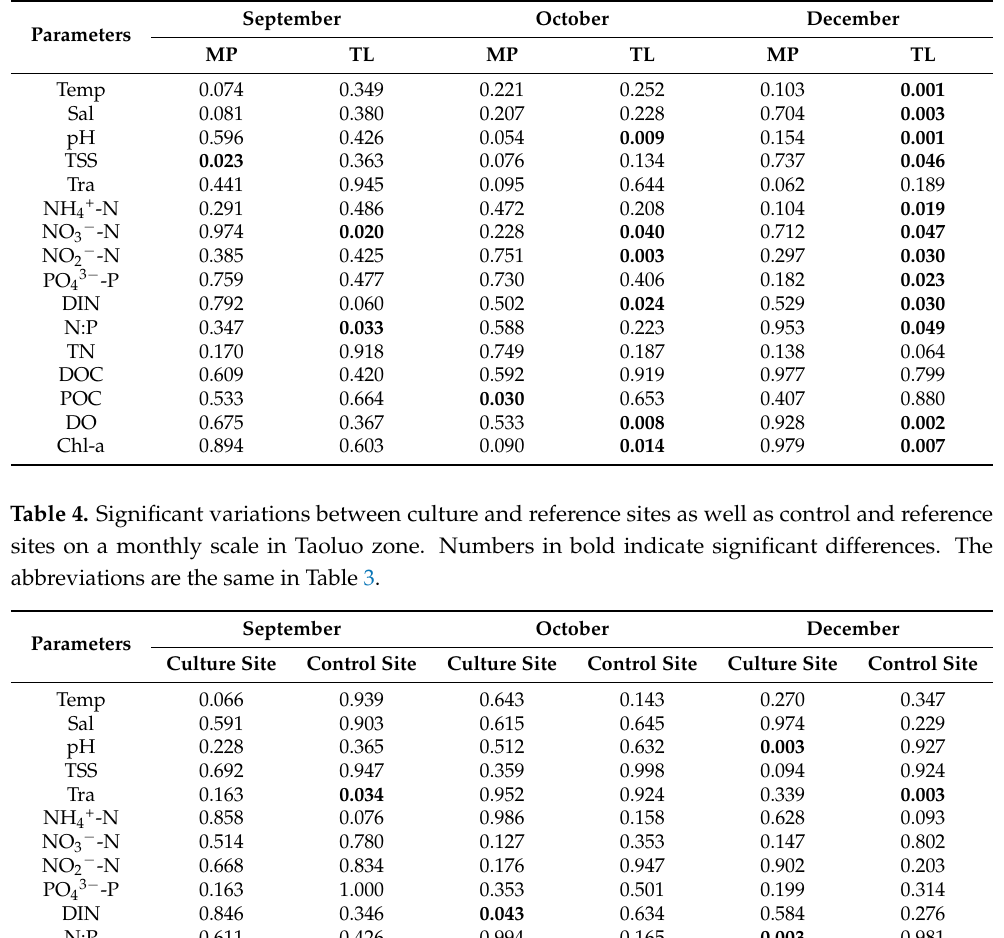
Table 3. Significant variations between culture and control sites on a spatial and temporal scale. Num- bers in bold indicate significant differences. MP: Muping zone; TL: Taoluo zone; Temp: temperature;